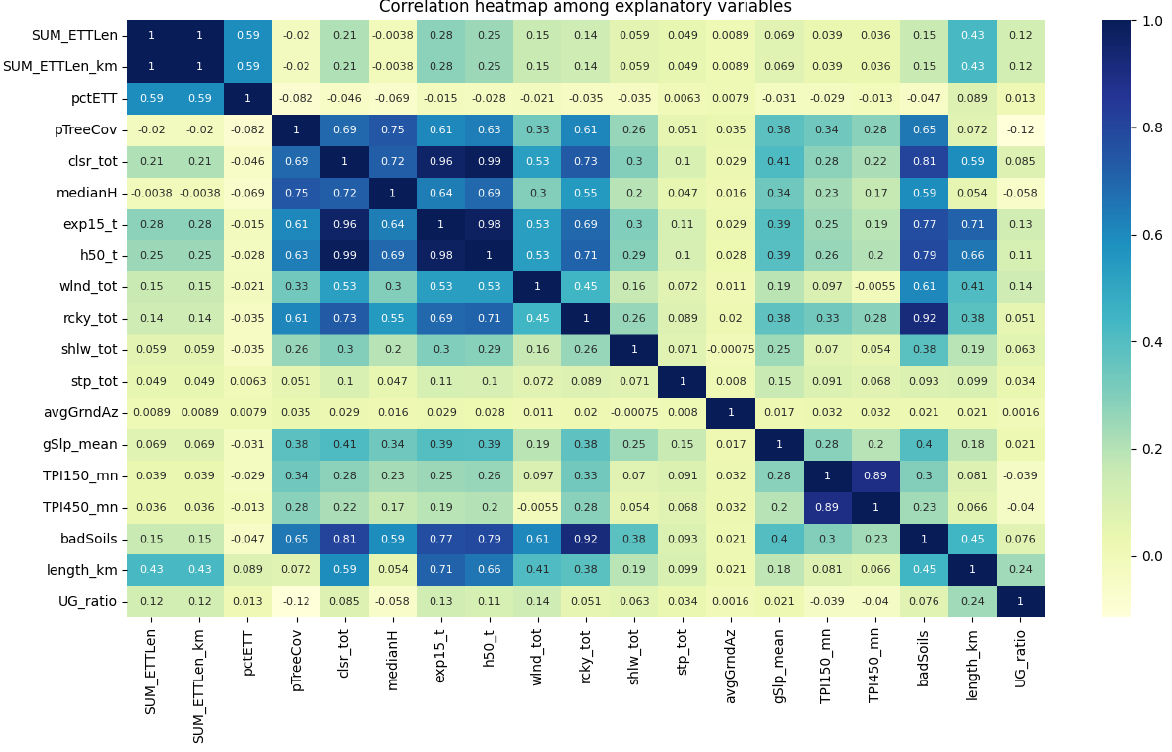
Figure 3. Correlation heatmap among explanatory variables